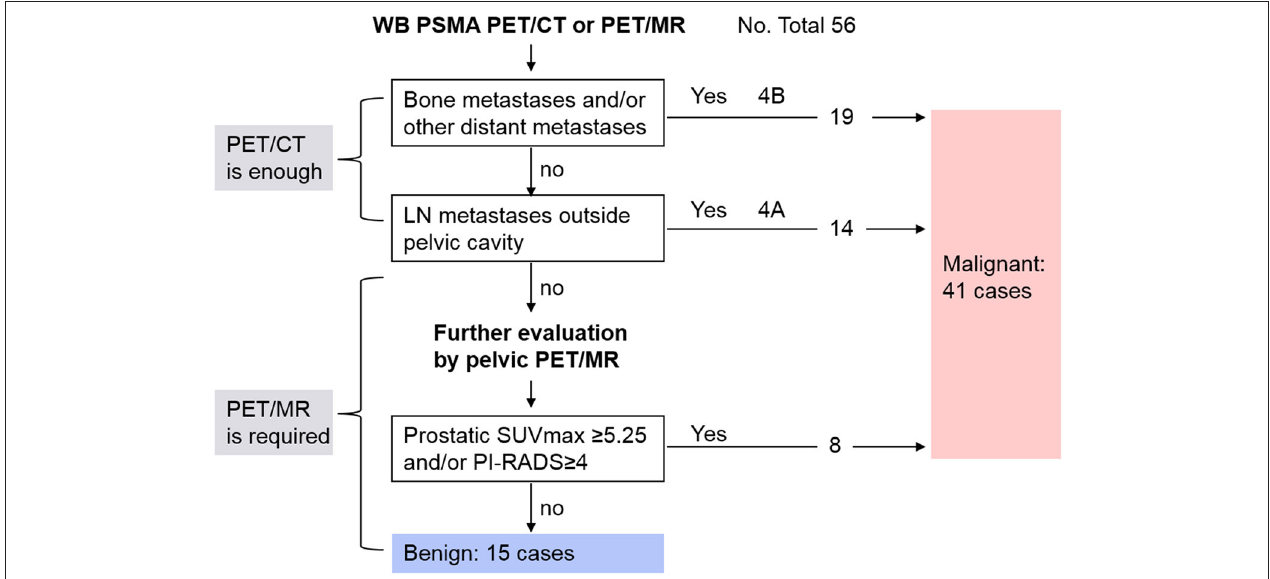
FIGURE 5 | Diagnostic overview of all patients in this study. LN, lymph node.